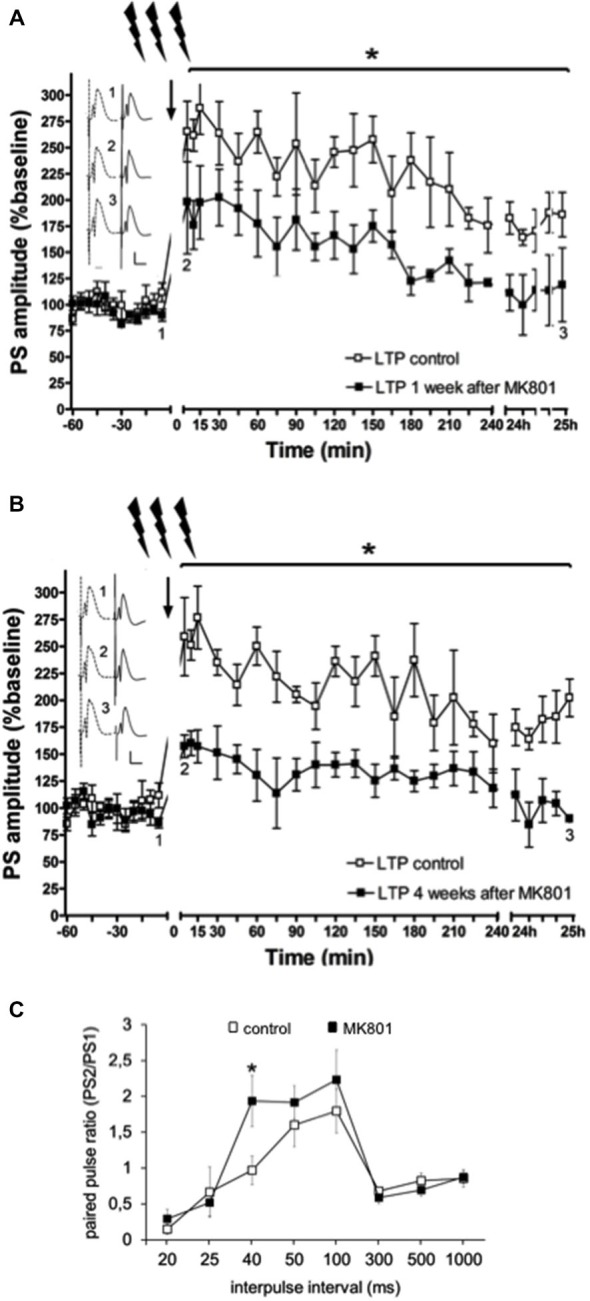
Electrophysiological responses following MK801-treatment. (A) MK801-treatment impairs LTP. High frequency stimulation (HFS) elicits robust LTP that persists for over 24 h in animals that were treated 1 week (A), or 4 weeks (B) previously with vehicle. In contrast, LTP is profoundly impaired 1 (A), or 4 weeks (B) after MK801-treatment. Insets: Analogs (control—dashed line, MK801—black line) were obtained 1, pre-HFS, 2, 5 min post-HFS and 3, 24 h post-HFS. Vertical scale-bar corresponds to 5 mV, horizontal scale-bar to 10 ms. *p < 0.05. (C) Paired-pulse (PP) responses are facilitated at the 40 ms interval after MK801-treatment. The graph shows PP responses at the interpulse intervals (IPI) of 20, 25, 40, 50, 100, 300, 500 ms and 1 s. The PP ratio was determined by dividing the amplitude of the second population spike (PS) in mV divided by the amplitude of the first PS (PS2/PS1). PP facilitation was evident at the 40 ms IPI after a single MK801-injection. Responses were unaffected at all other IPIs. *p < 0.05.